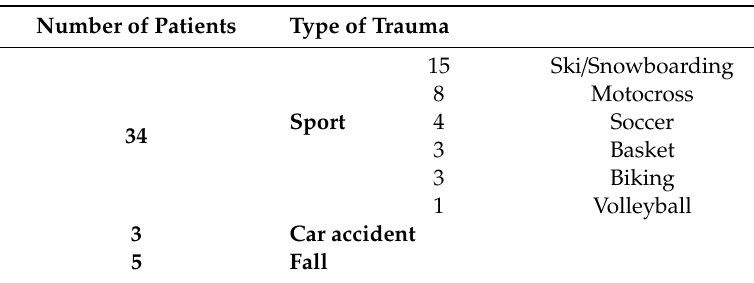
Table 1. Causes of Table 1. Causes of fracture.